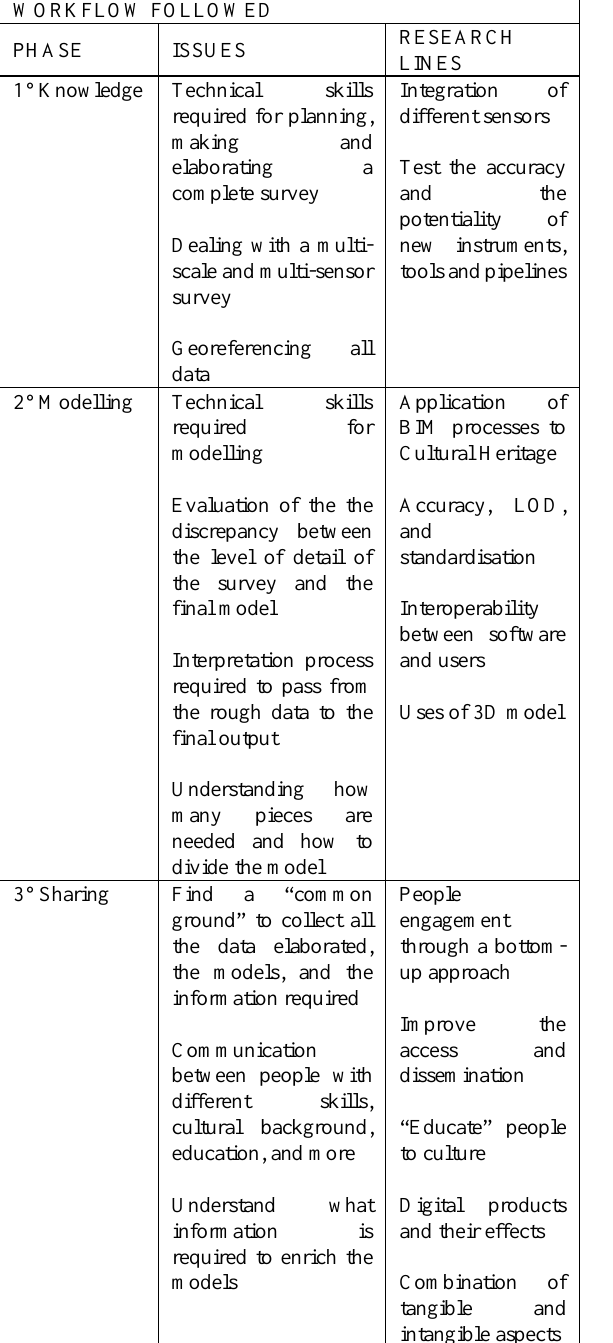
Figure 13: The entire process of